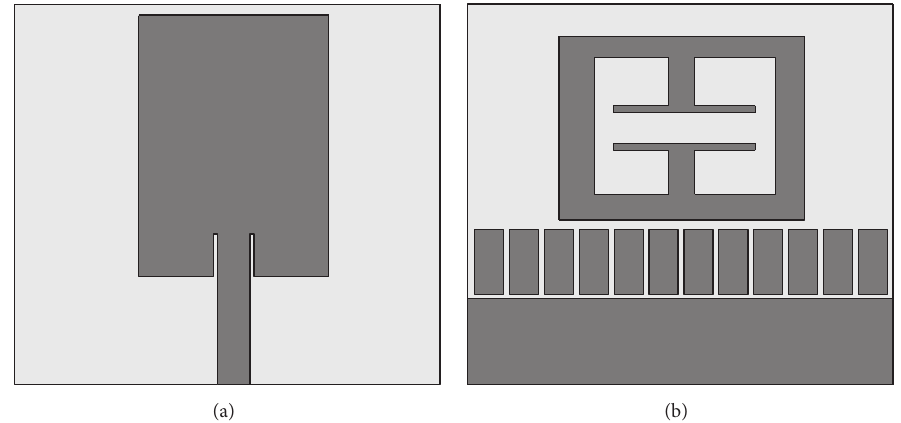
Figure 38: Geometry of a small metamaterial antenna with ELC structure [100]. Front view (a) and back view (b). Dark gray upper metal face and light gray dielectric substrate.